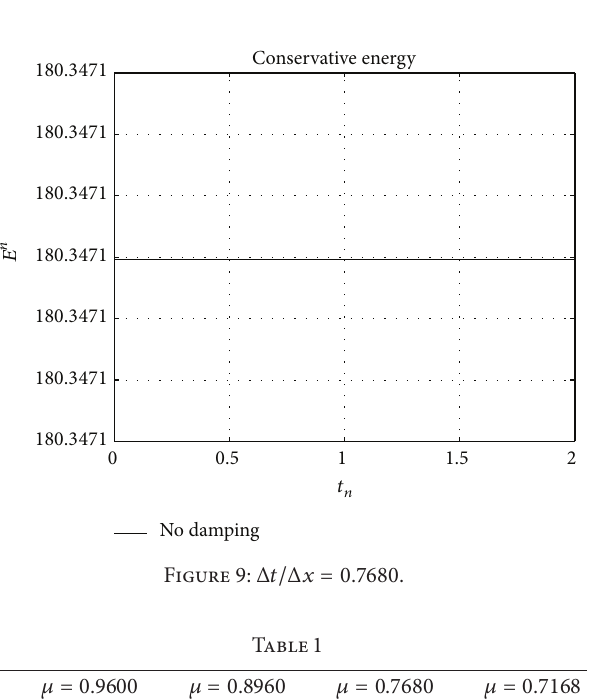
Figure 10: Δ𝑡/Δ𝑥 = 0.7168 .